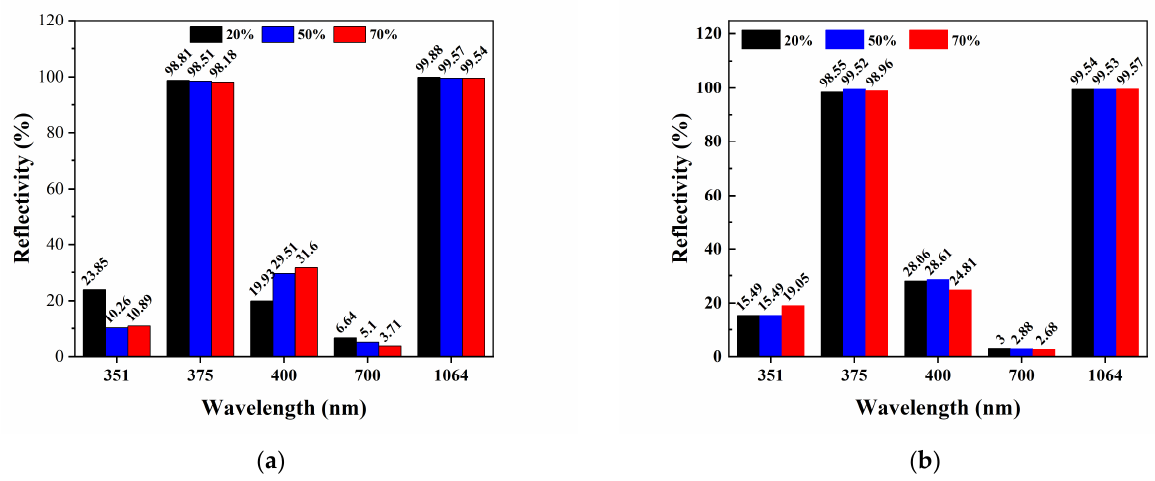
Figure 5. The reflectivity at 351 nm, 375 nm, 400 nm, 700 nm, and 1064 nm wavelengths of samples stored for four weeks in different humidity environments: ( a ) SiO 2 and ( b ) K9.